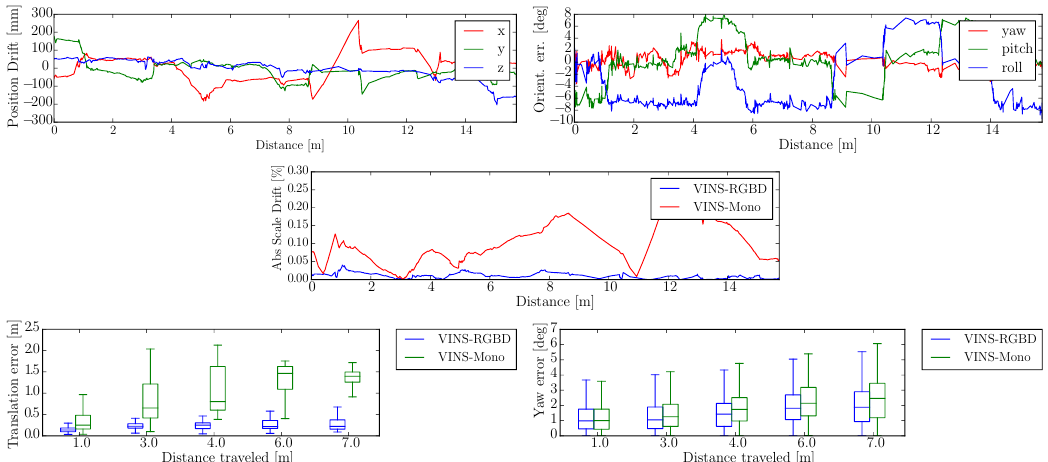
Figure 18. Tracked Robot Absolute and Relative Error in the “Cross and Up-down Slopes and Ground” experiment. The first row shows the absolute position and orientation error of our system. The relative translation and yaw error together with the scale drift percentage comparison of our VINS-RGBD and VINS-Mono are shown in the last two rows.